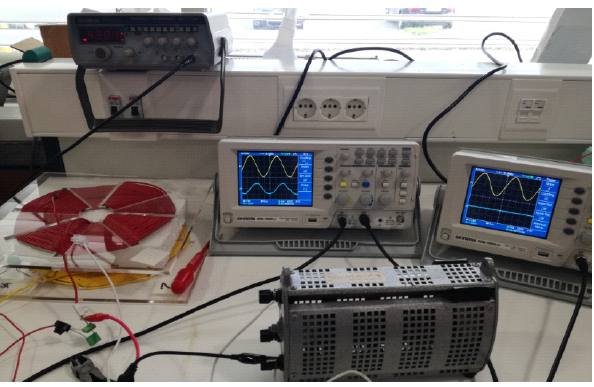
Figure 11. Experimental setup used to characterize the resonant inductive coupling. The WPT resonant frequency is set to ISO kHz as a good agreement between efficiency and low electronic complexity. The results of the transmission distance are experimentally verified and the graphs of the relationship between transmission distance and mutual inductance are shown in Figure 12a while that between transmission distance and the frequency is also represented in Figure 12b.